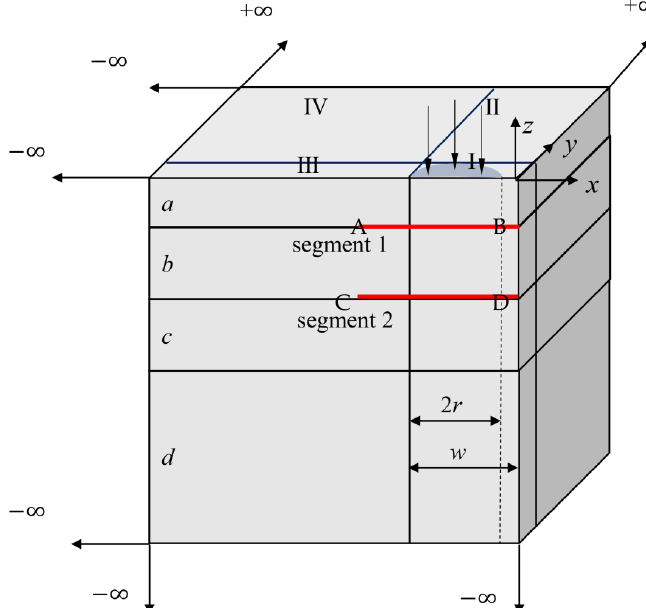
Figure 12. Quarter of meshless FBM with infinite block modeling.